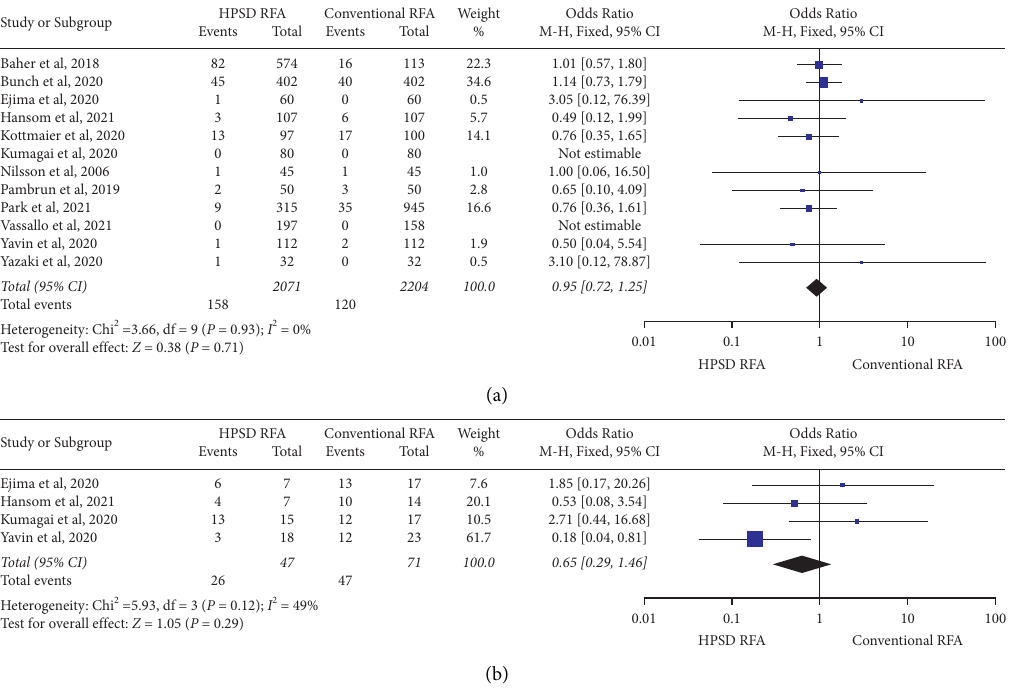
Figure 4: Forest plots of the primary pooled analysis demonstrating the effect of high-power short-duration RFA vs. conventional RFA in patients with atrial fibrillation. Data are events in each group and weighted odds ratios. )e horizontal line is the 95% CI. )e diamond shape is the pooled mean difference of all studies. CI: confidence interval; RFA: radio frequency ablation; PVR: pulmonary vein reconnection. (a) Total complications. (b) PVR during redo